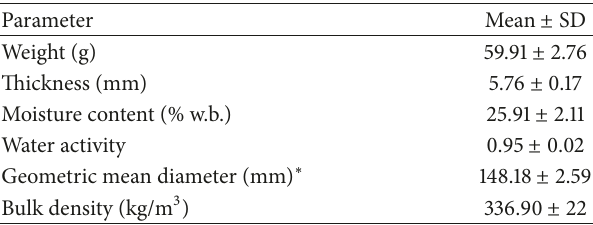
Table 1: Physical properties of PB loaves.